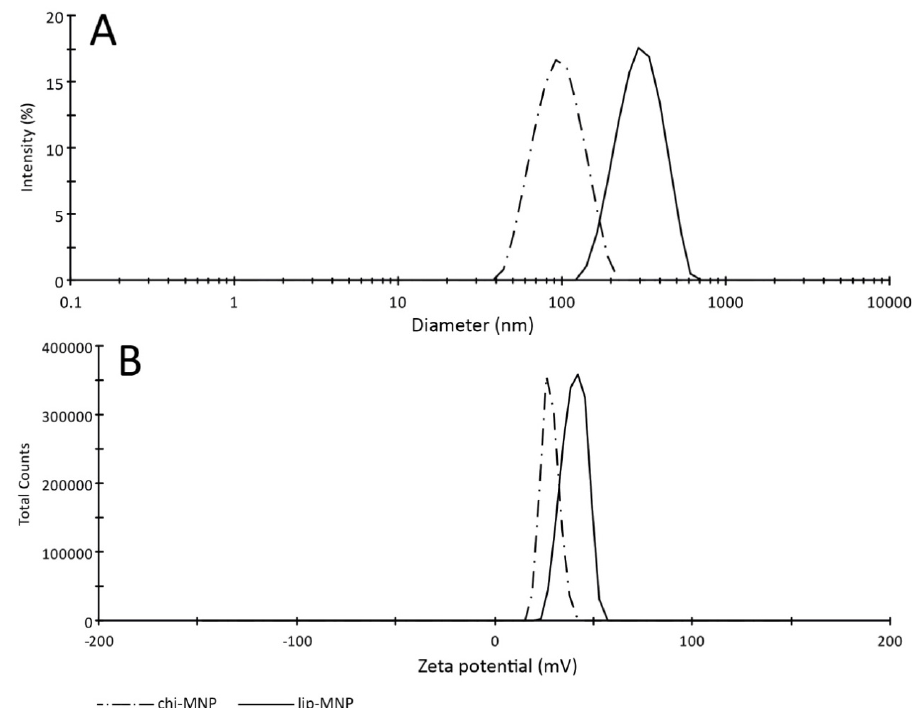
Figure 2. Size ( A ) and ζ -potential ( B ) characterization of nanoparticles. The size (nm) and ζ -potential (mV) was assessed using a Zetasizer Nano for chi-MNPs (dashed line) and lip-MNPs (solid line). The size (A) and ζ -potential (B) readings as assessed by the Zetasizer Nano. Triplet measurements were conducted for both size (nm) as well as ζ -potential for both chi-MNP (dashed line) and lip-MNP (solid line).